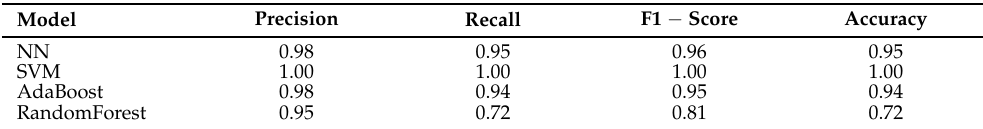
Table 6. Results of classification methods with SMOTE.